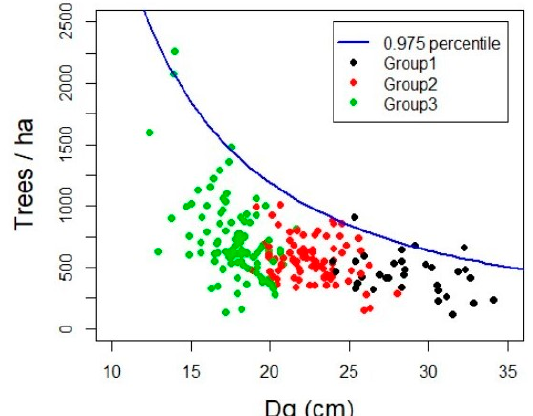
Figure 4. Maximum density estimated by percentile regression for the 217 plots. The three forest types are identified by different colors. Dq: Quadratic mean diameter.